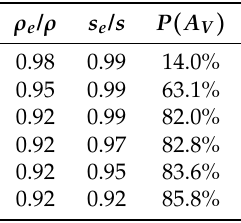
Figure 4. Closed-loop trajectory under the Safeness Index-based LEMPC of Equation (6) for the initial condition (0, 0) (in deviation variable form) with the additional material constraint: 1 0 kmol/m 3 .